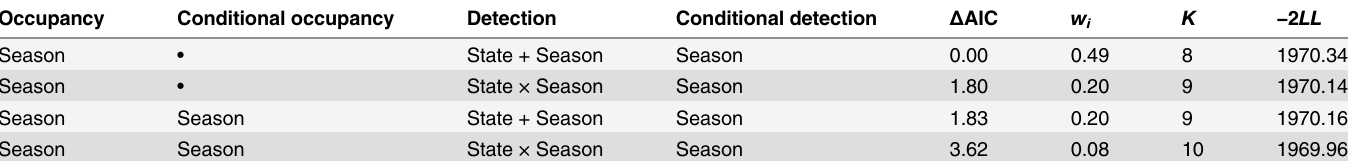
Table 3. Multistate, multiseason models fitted to the rusa adult male camera trap data collected in winter and summer.